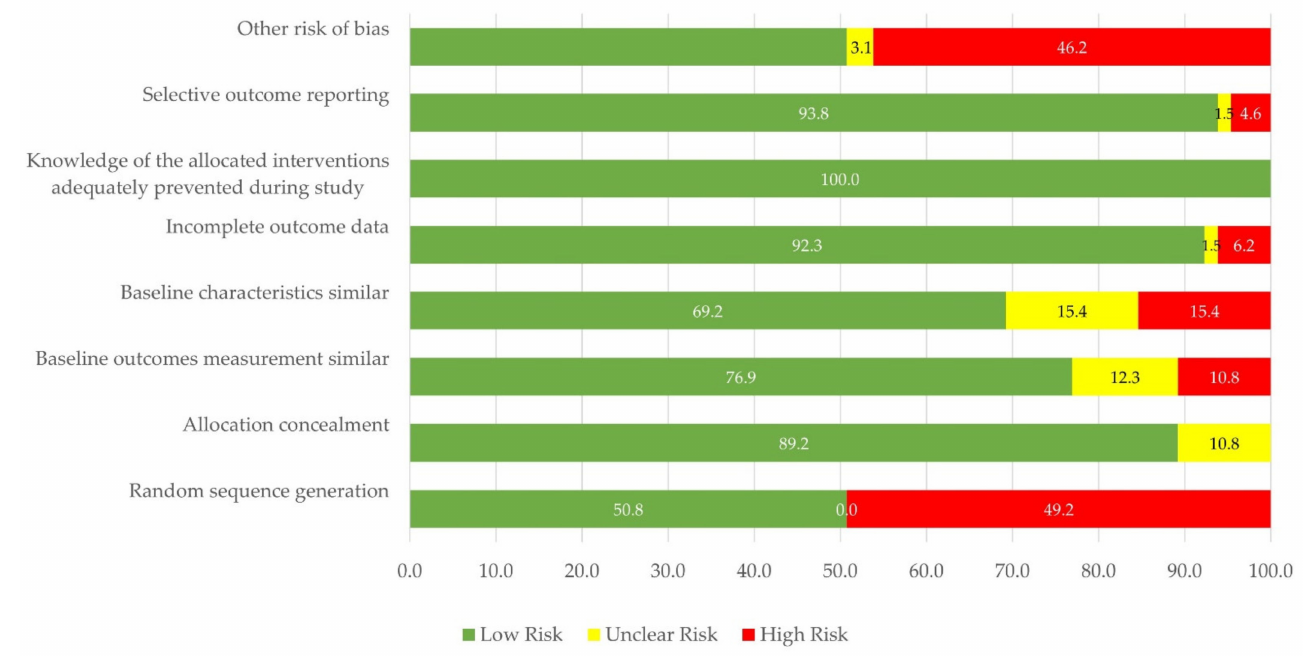
Figure 3. Risk of bias graph—an analysis of the 8 evaluation